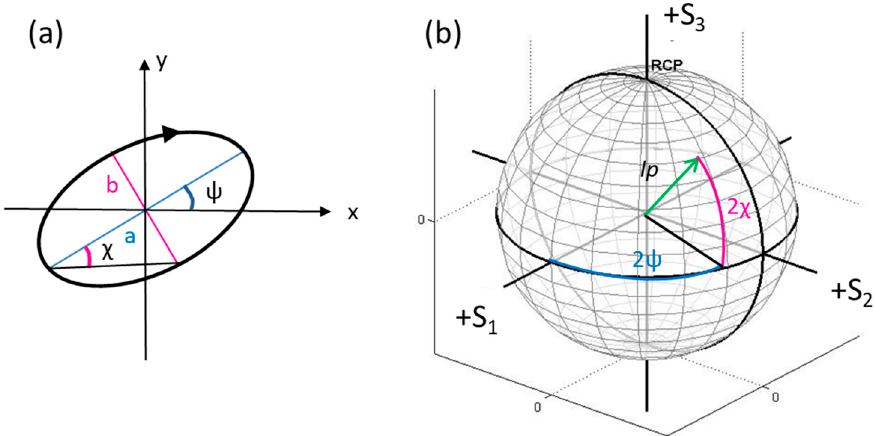
Figure A1. ( a ) Polarization ellipse, showing the relationship to the Poincaré sphere parameters ψ and χ . In particular, the orientation angle ψ is the angle between the major axis of the ellipse and the x -axis along with the ellipticity ε = a / b, the ratio of the ellipse’s major to the minor axis (also known as the axial ratio). The ellipticity parameter is an alternative parameterization of the ellipticity angle, χ = arctan(b / a) = arctan(1 / ε ) [15,79]. ( b ) The Poincaré sphere is the parameterization of the last three Stokes’ parameters in spherical coordinates.